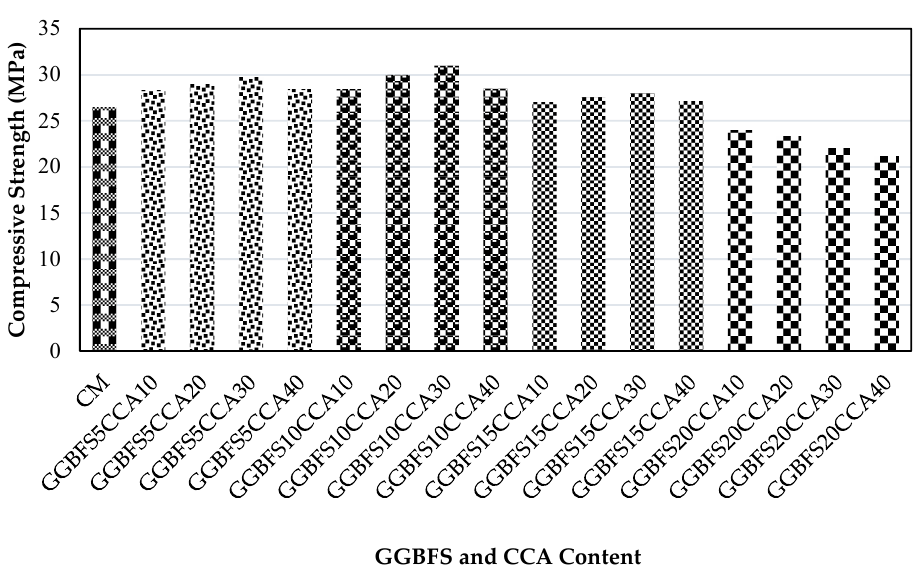
Figure 11. Compressive strength of concrete blended with GGBFS along with CCA.